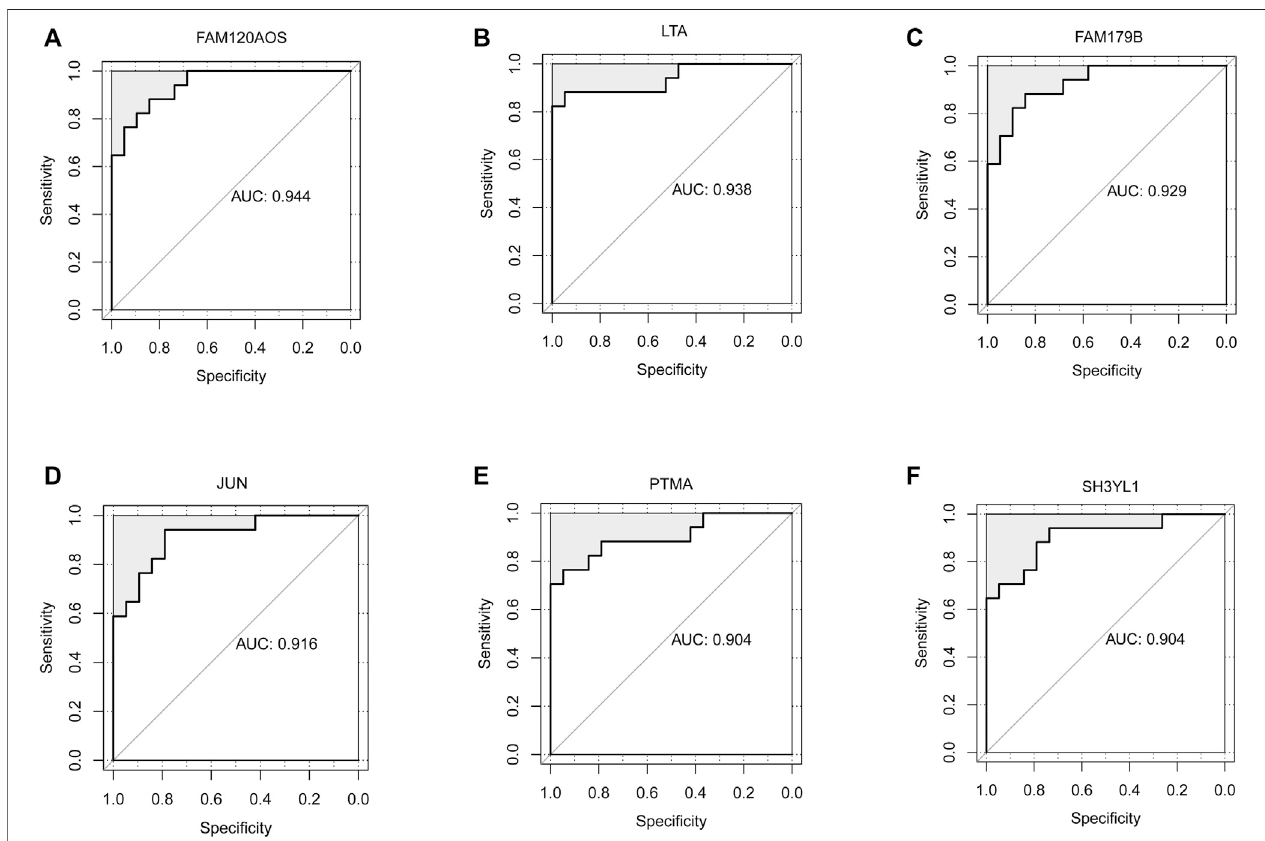
FIGURE3| Identi fi cationofdiagnosticmarkersbyROCanalysis. (A – F) ROCcurvesshowedtheAUCvaluesofFAM120AOS (A) ,LTA (B) ,FAM179B (C) ,JUN (D) , PTMA (E) , SH3YL1 (F) .